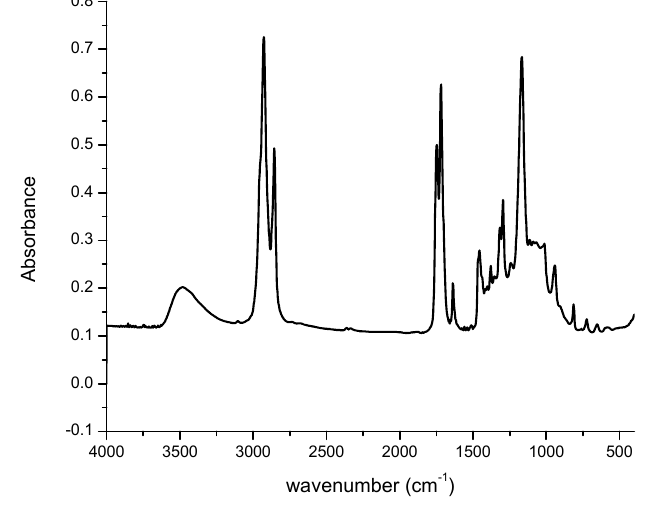
Figure 4. Fourier transform infrared spectrum of MESS. Table 2. Functional group assignments on the MESS FTIR spectrum.